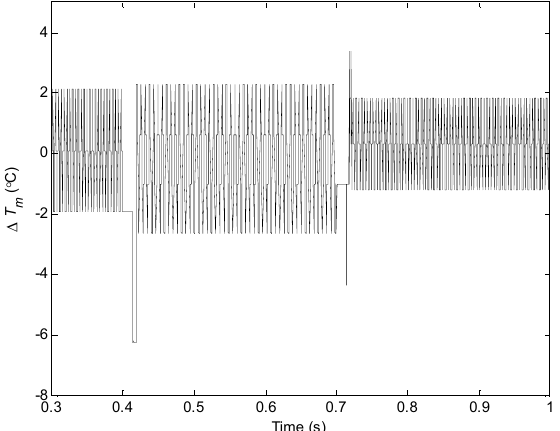
Figure 23. T  curve under increasing S conditions. Figure 23. ∆ T m curve under increasing S m